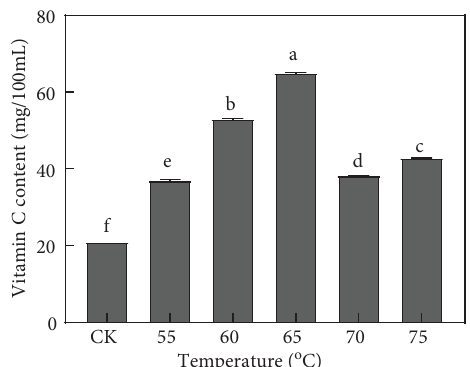
Figure 3: Vitamin C content of “Yali” pear paste prepared under traditional and vacuum concentrations with diferent tempera- tures. CK: pear paste under traditional heating concentration; 55 ° C, 60 ° C, 65 ° C, 70 ° C, and 75 ° C: pear paste at diferent vacuum con- centration temperatures; diferent letters indicated signifcant diferences among groups ( p < 0 . 05).